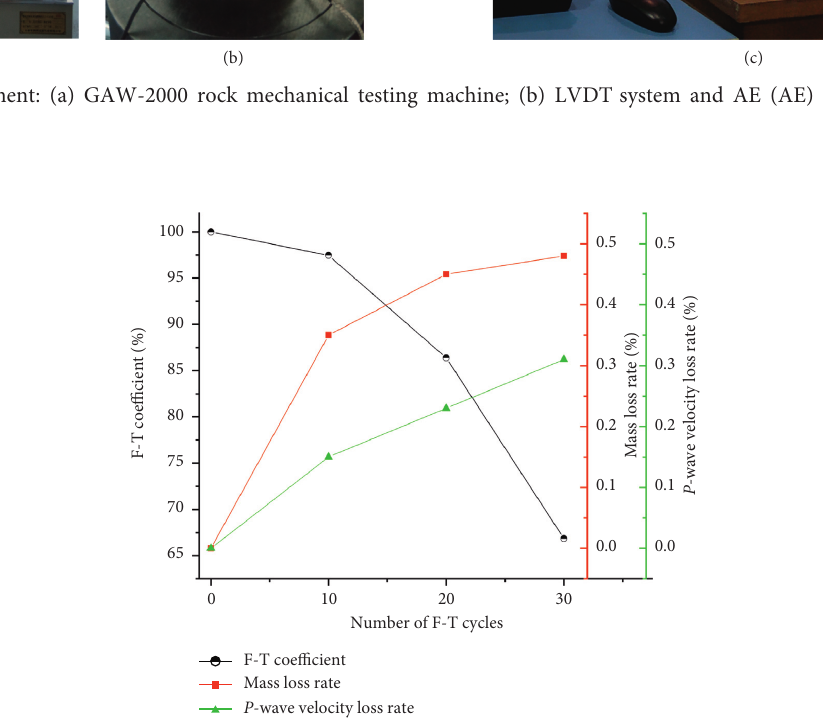
Figure 5: Relationship curves of the F-T coefficient, mass loss rate, and the P-wave velocity loss rate with the F-T